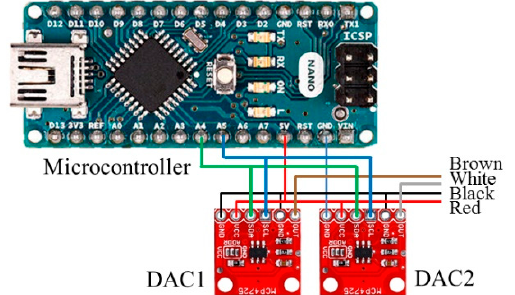
Figure 4. The schematic configuration of the acceleration/brake-by-wire system.